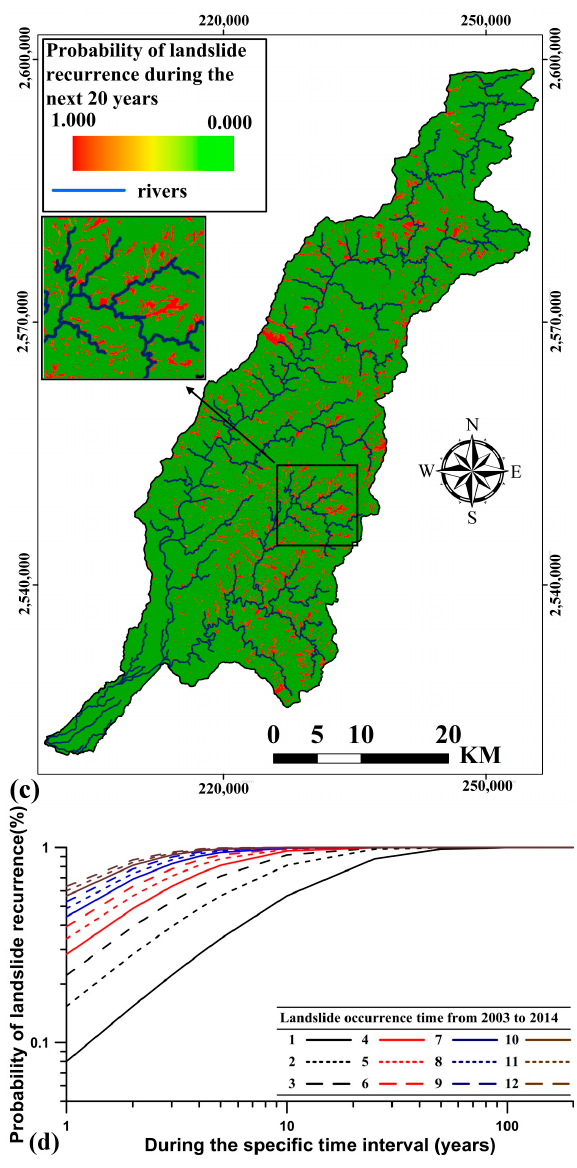
Figure 10. The probability distribution of landslide recurrence during the next 5 ( a ), 10 ( b ), and 20 ( c ) years in the LRW. ( d ) Explains the landslide recurrence probability during the next specific time interval based on the landslide occurrence time from 2003 to 2014 in the LRW.